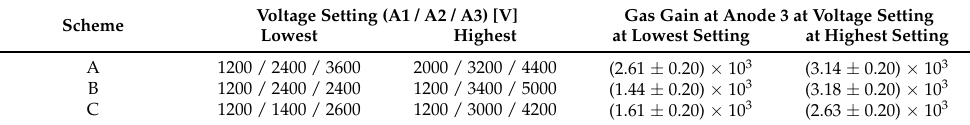
Table 6. The charge gain measured at the highest at lowest voltage settings of each voltage scheme.